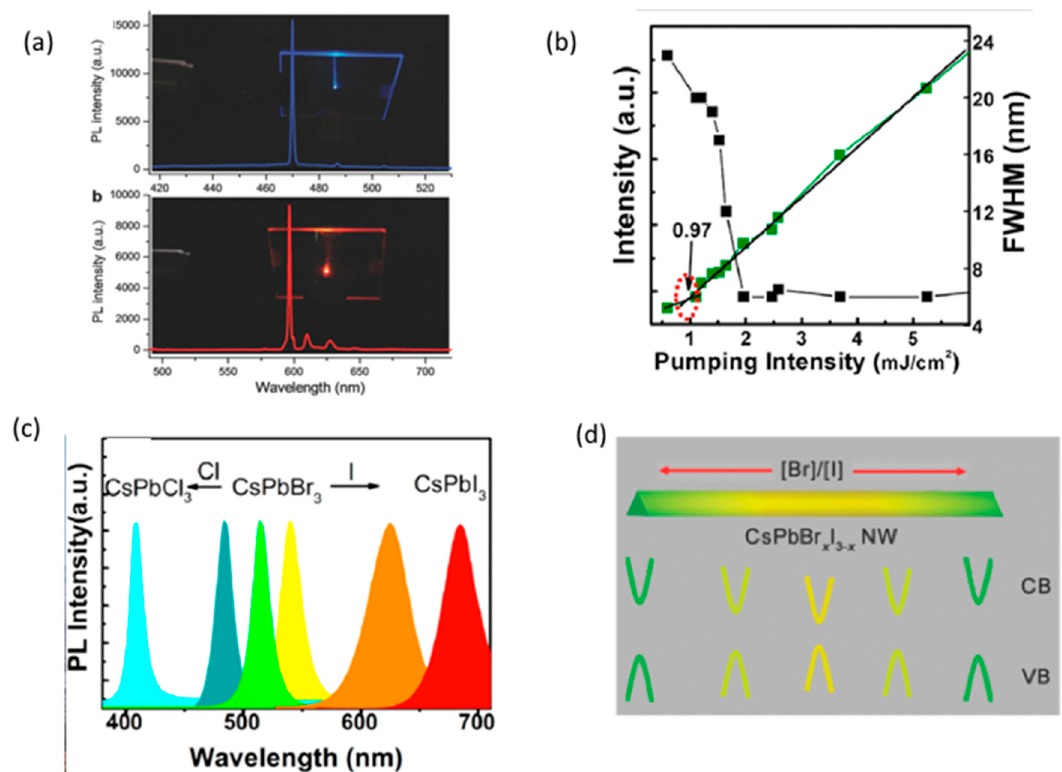
Figure 5. ( a ) Single Mode Laser Operation at blue and red colour from CsPb(Br/Cl) 3 and CsPb(I/Br) 3 IPNCs under pump intensity of 38.2 and 30.5 µ J cm − 2 , respectively. Reproduced with the permission from Wang et al. [63], Advanced Functional Materials; published by Wiley-VCH, 2017. ( b ) The transition from the spontaneous emission to stimulated emission is accompanied by a simultaneous non-linear increase of the Intensity above threshold and at the same time a shrieking of the emission spectral linewidth; in this figure the lasing behaviour of CsPbBr 3 NC film. Reproduced with permission from Tang et al. [70], Nano Energy; published by Elsevier, 2016. ( c ) Tunability of the emission PL light achieved through different composition. Reproduced with permission from Tang et al. [70], Nano Energy; published by Elsevier, 2016. ( d ) Dual Wavelength Lasing through structure of composition-graded CsPbBr x I 3 − x NW and the graded bandgap. Reproduced with permission from Huang et al. [62], Advanced Materials; published by Willey-VCH, 2018.